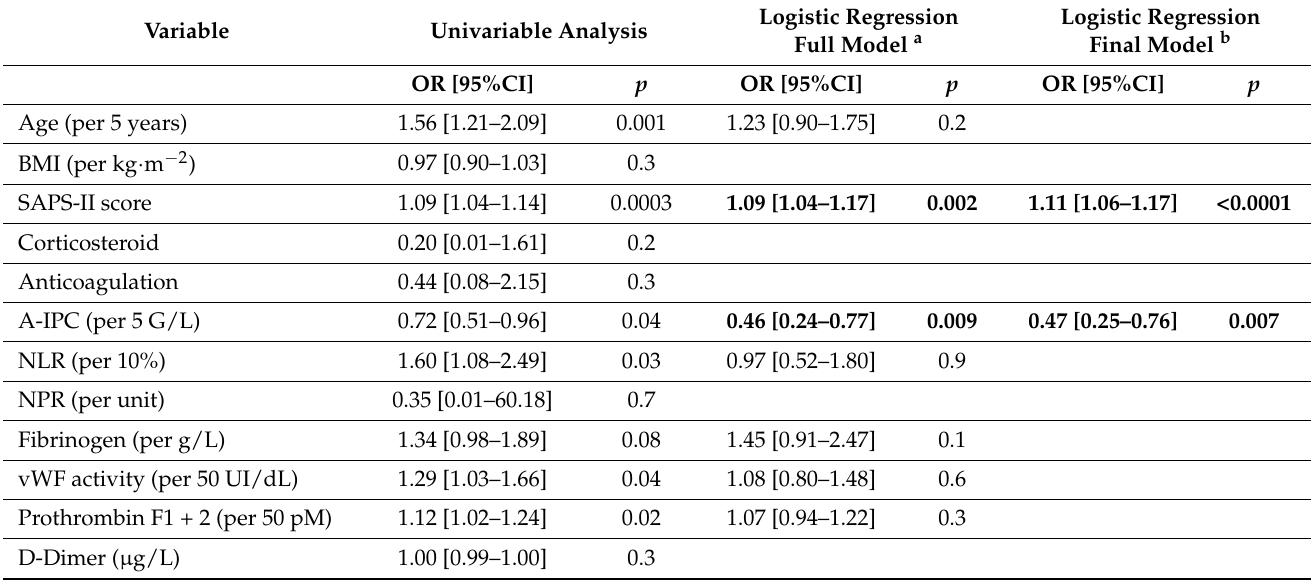
Table 5. Associations between clinical and biological variables at ICU admission and worsening toward critical condition during the ICU